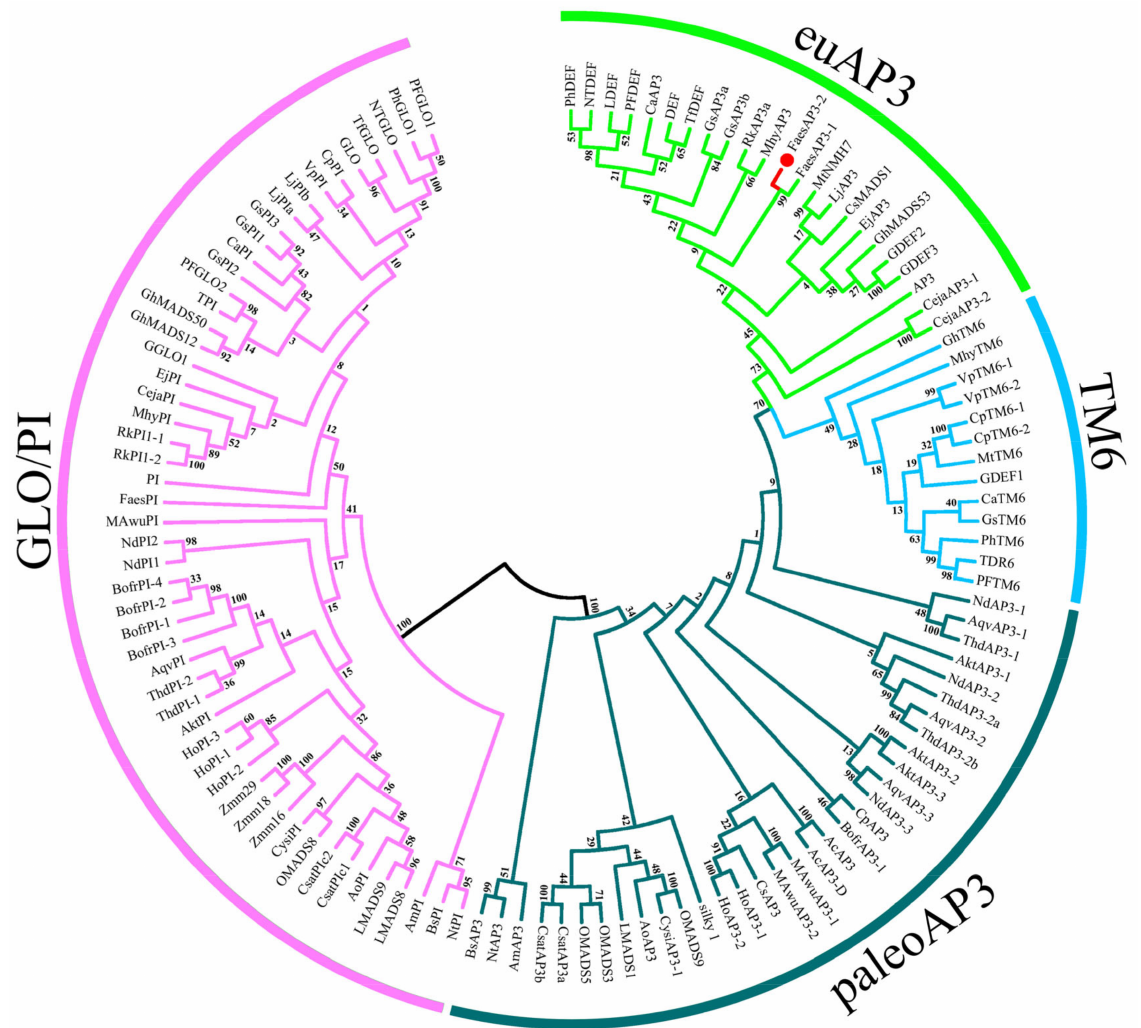
Figure 3. Phylogenetic tree of FaesAP3_2 and other B-class MADS-box transcription factors from different clades of